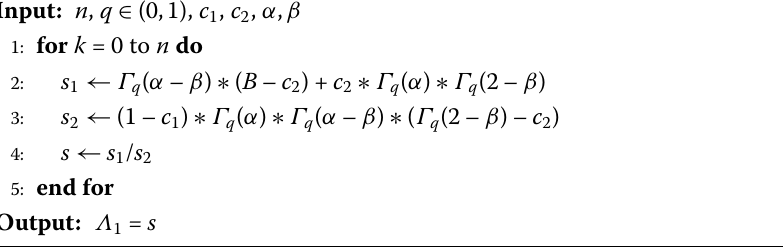
Algorithm 6 The proposed method for calculating Λ 1